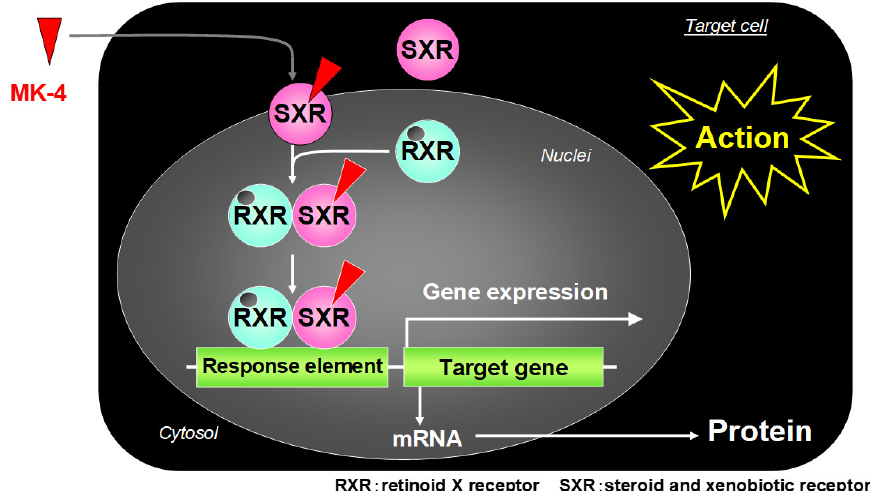
Figure 3. Transcription regulatory action of menaquinone-4 (MK-4) via the nuclear steroid and xenobiotic receptor (SXR).